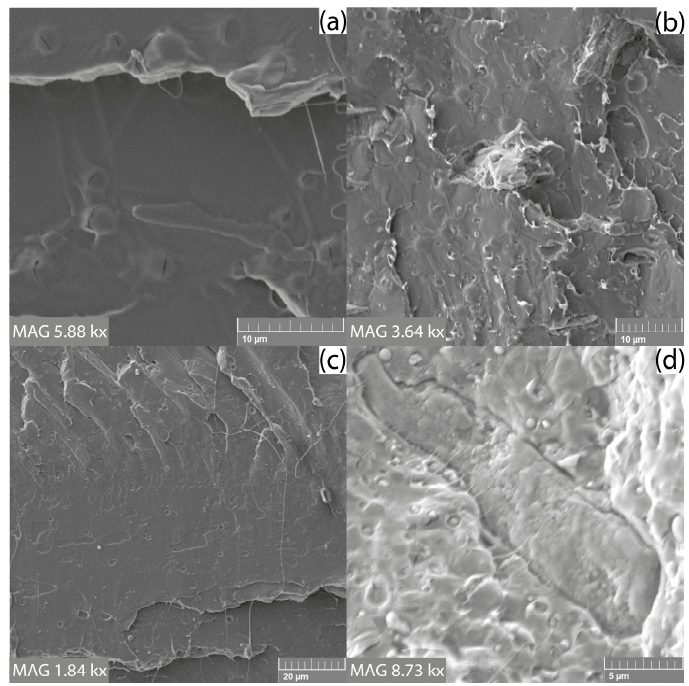
Figure 2. SEM analysis of fractured surfaces: ( a ) PLLA, ( b ) PLLA/SCG, ( c ) PLLA/PLLA-g-IA, and ( d ) PLLA/PLLA-g-IA/SCG.